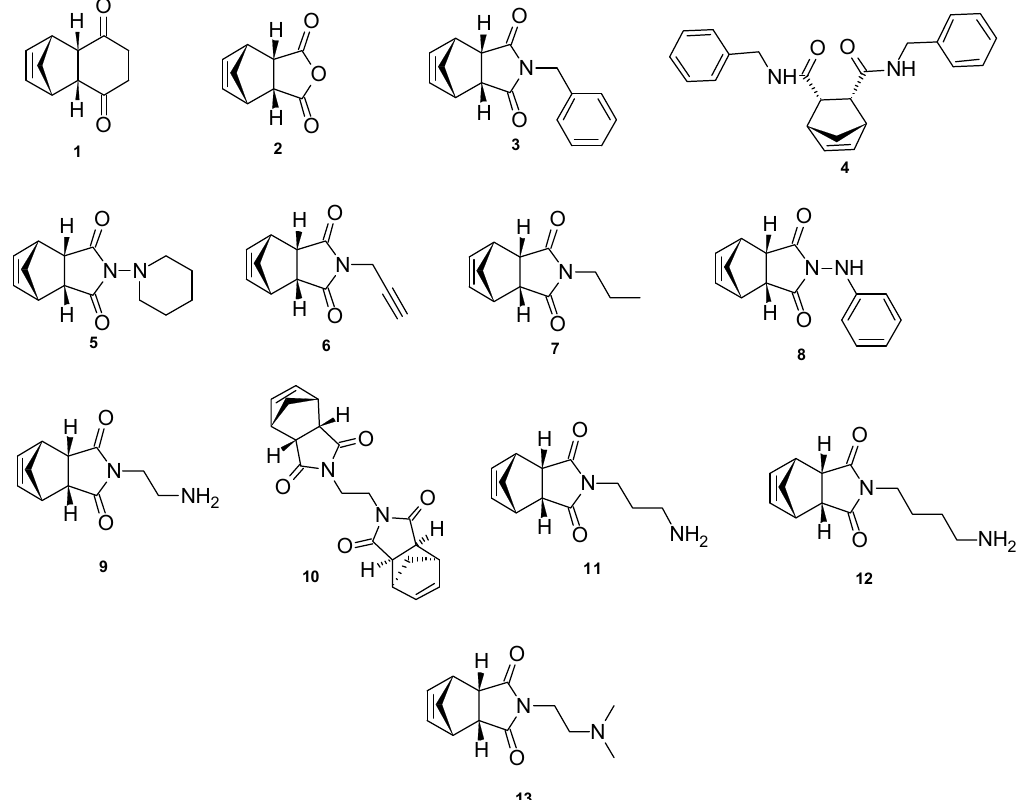
Figure 3. 4-Oxatricyclo[5.2.1.0 2,6 ]dec-8-ene-3,5-dione derivatives evaluated in this study.